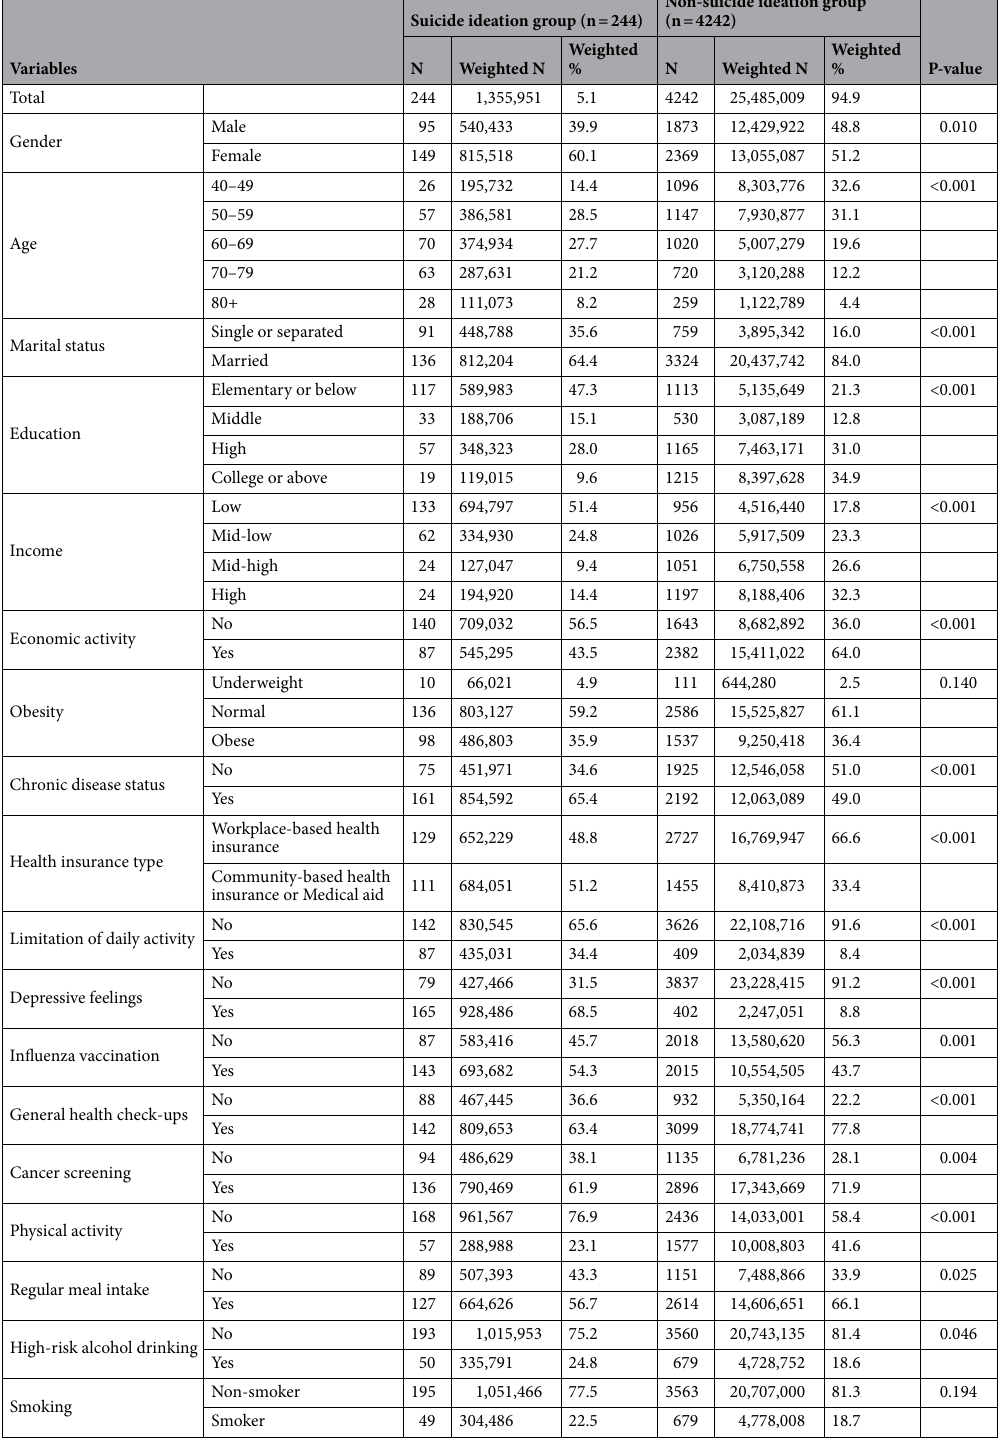
Table 1. Characteristics and preventive health behaviors among suicide ideation group and non-suicide ideation